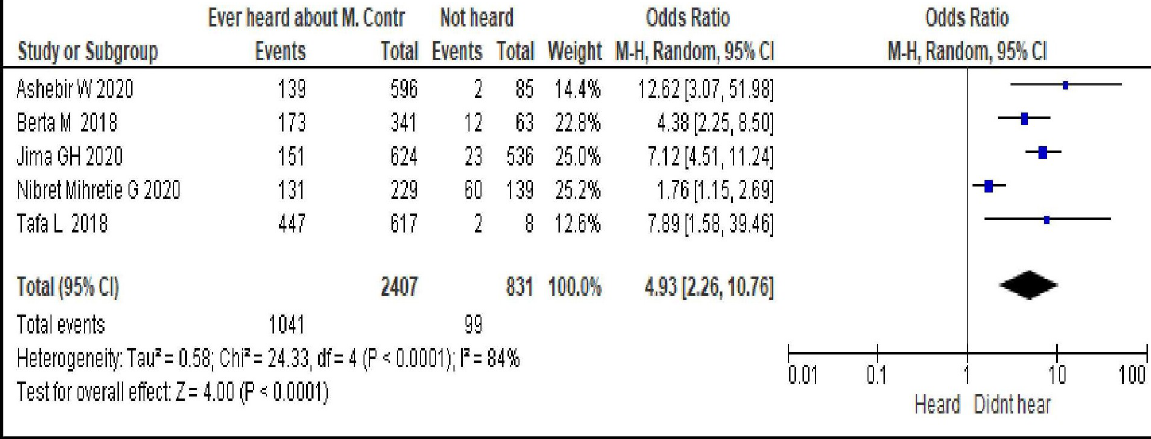
Fig 7. Association between women’s previous information about modern contraceptive use during postpartum period and its uptake, 2021.